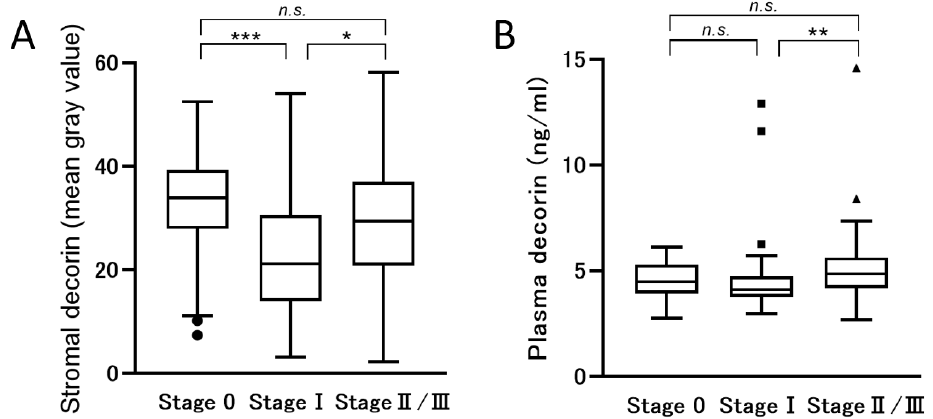
Figure 1. The plasma levels of DCN were elevated in the patients with advanced-stage breast cancer. ( A ): The quantified stromal expression of decorin was compared among the three groups, including clinical stage of carcinoma in situ (Stage 0), Stage I, and Stages II and III. ( B ): The concentration of decorin in plasma was similarly compared. Data were analyzed using one ‐ way ANOVA and post hoc Holm–Bonferroni method in Figure A and using Kruskal–Wallis test and post hoc Steel–Dwass test in Figure B. Data showed box ‐ and ‐ whisker plot and *, **, *** indicated statistically significant p < 0.05, <0.01, and <0.001, respectively.